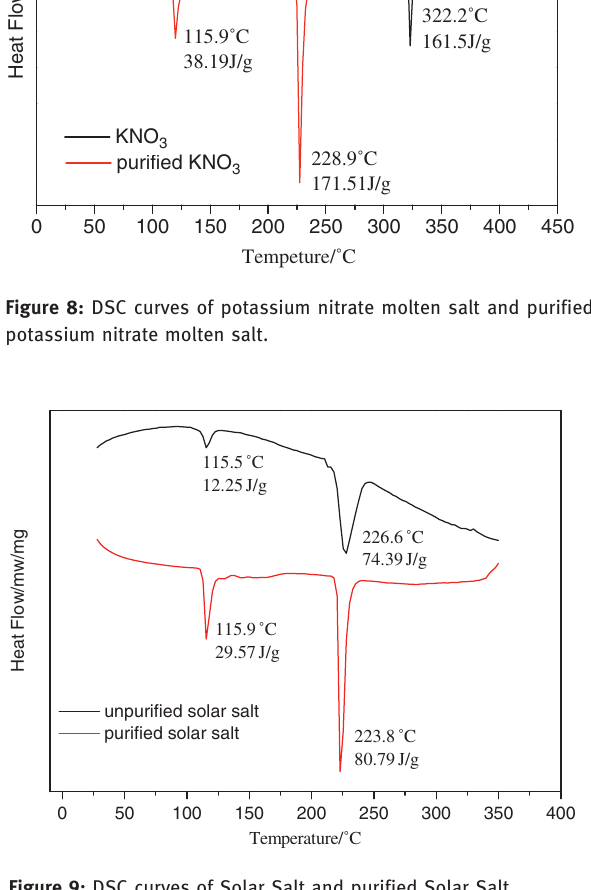
Figure 9: DSC curves of Solar Salt and purified Solar